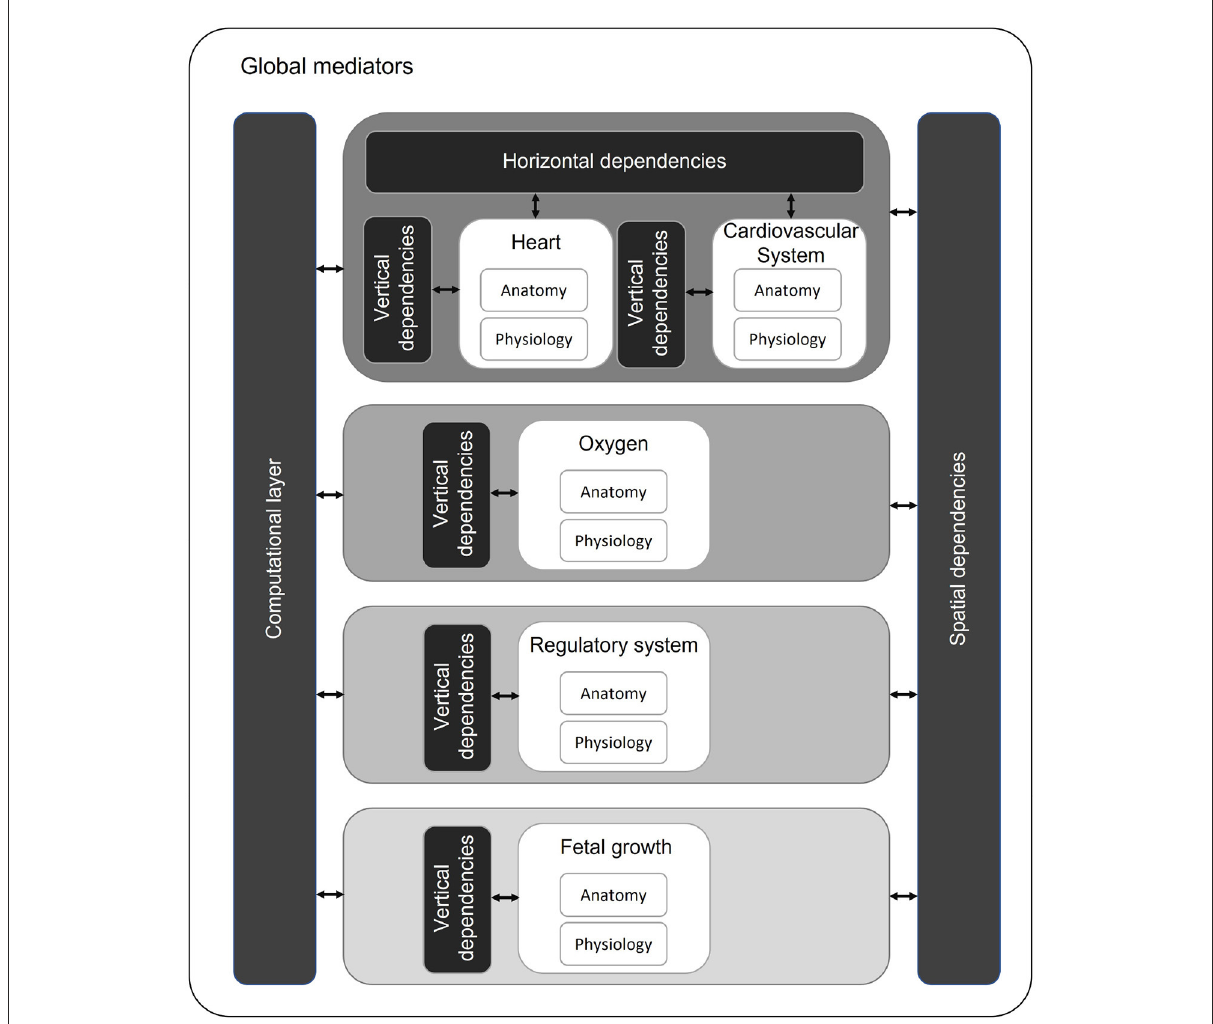
FIGURE4 Proposed multiscale and multilevel approach with modules (white) organized on time scales (gray scale). Modules with the same time and length scale can have horizontal dependencies. Within a module, multilevel approach can be required (vertical dependencies). Over different time scales, modules influence each other (spatial